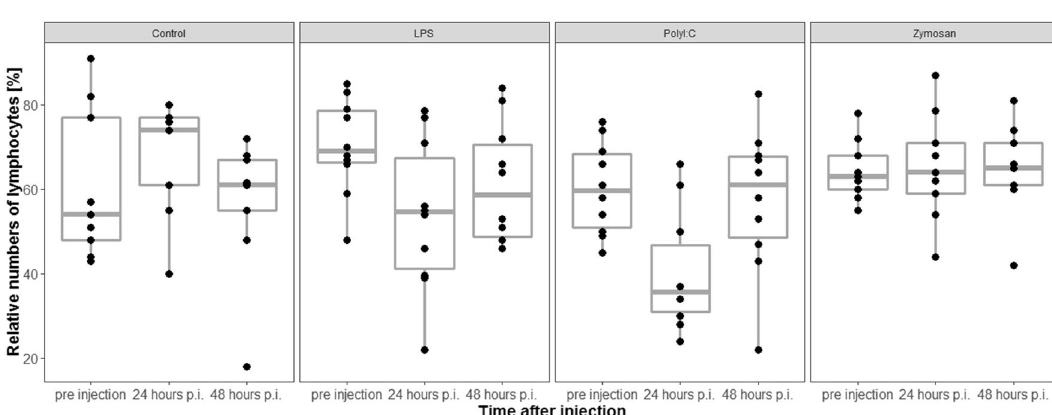
Figure 6. Relative numbers of lymphocytes significantly decreased in LPS- and PolyI:C treated individuals compared with control individuals 24 h p.i. = post injection. The figures show medians (bold line), 25–75% percentiles (box), maxima and minima (whiskers) and data points Total leukocyte count changes. The total number of leukocytes did not differ across treatment groups before injection of antigen/saline solution (LRT, df = 3, χ 2 = 10.15, p = 0.92, n = 38). Treatment and the interac- tion between sampling time and treatment did not affect the change in the total leukocyte counts of individuals compared to before the injection (LRTs, model with interaction vs. model without interaction: df = 3, χ 2 = 0.78, p = 0.85; model with treatment vs. model without treatment: df = 3, χ 2 = 1.61, p = 0.666, Fig. 5). Relative numbers of lymphocytes. Relative numbers of lymphocytes (%) did not differ across treatment groups before injection of antigen/saline solution (LRT, df = 3, χ 2 = 9.64, p = 0.92, n = 38). The interaction between treatment and sampling time was significant (LRT, model with interaction vs. model without interaction: df = 3, χ 2 = 12.36, p = 0.006, Fig. 6). Because we were only interested in comparisons across treatments for the same sampling time, we restricted our post hoc analyses to comparisons among treatment at 24 h and 48 h post injection (p.i.), respectively. Relative numbers of lymphocytes decreased in individuals treated with LPS or PolyI:C compared with individuals treated with saline solution 24 h p.i. (GLHT, saline solution vs. LPS: Estimate = − 24.18, SE = 7.52, z = − 3.21; p = 0.01; saline solution vs. PolyI:C: Estimate = − 27.88, SE = 7.52, z = − 3.71; p = 0.002). There were no differences between other combinations of treatment at 24 or 48 h p.i., respectively (GLHT, Estimate < 20.94; p > 0.053, respectively). Relative numbers of neutrophils. Relative numbers of neutrophils (%) did significantly differ across treatment groups before injection of antigen/saline solution (LRT, df = 3, χ 2 = 45.86, p < 0.001, n = 38, Fig. 7). Relative numbers of neutrophils tended to be lower in the LPS groups, thus in these animals there was a higher potential for an increase in neutrophil numbers compared with the other groups after injection of the antigen/ saline solution. The interaction between treatment and sampling time was significant (LRT, model with interaction vs. model without interaction: df = 3, χ 2 = 8.44, p = 0.038). Because we were only interested in comparisons across treatments